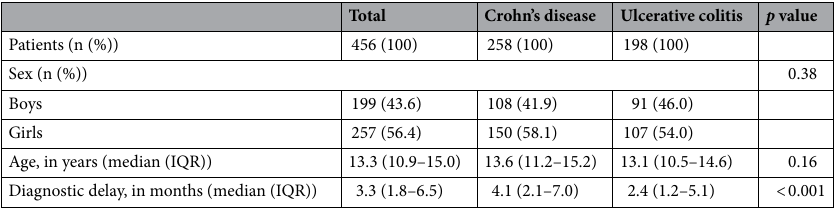
Table 1. Patient characteristics (sex, age, diagnostic delay) in total and by diagnosis. IQR interquartile range.